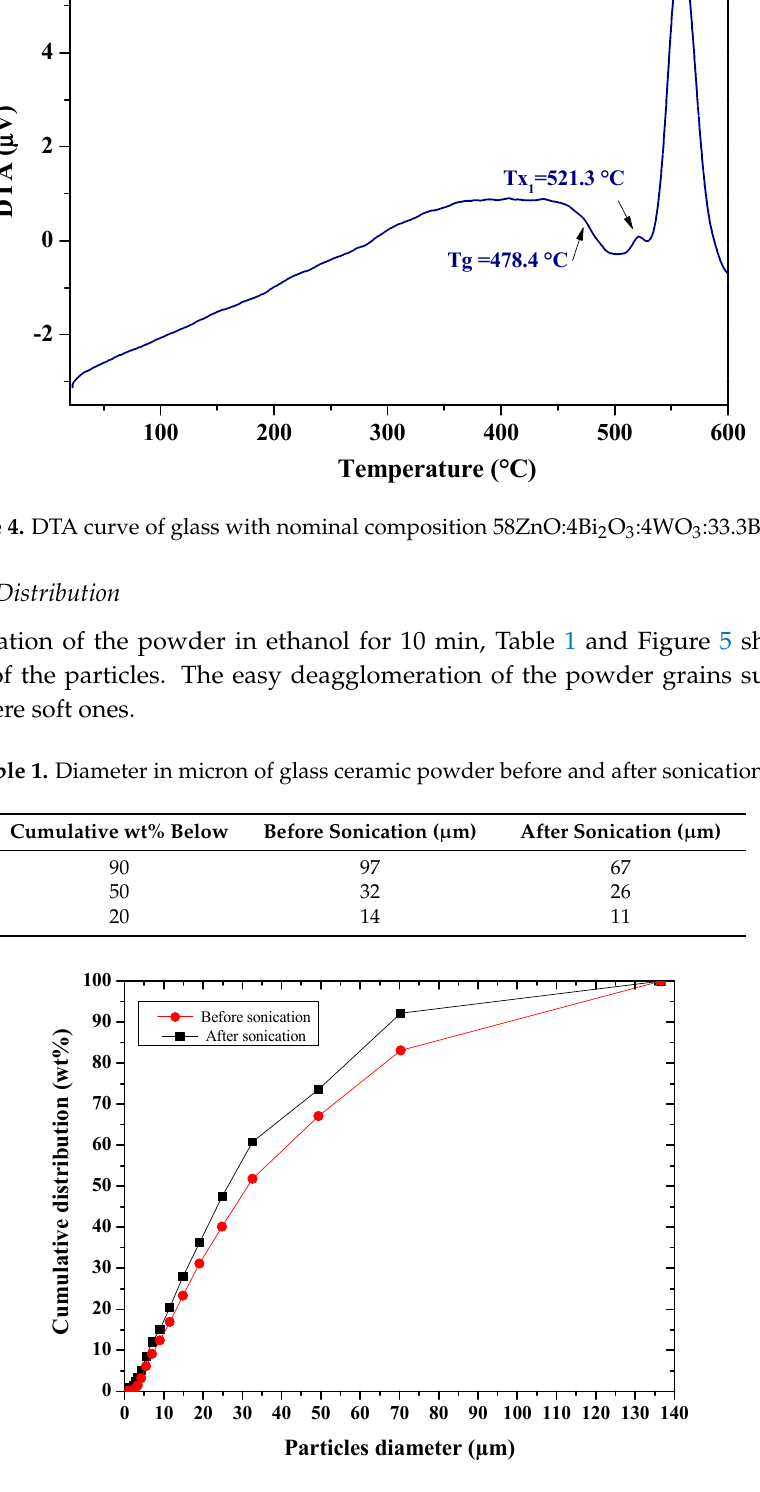
Figure 5. Particle size distribution of glass–ceramic powder before and after sonication.